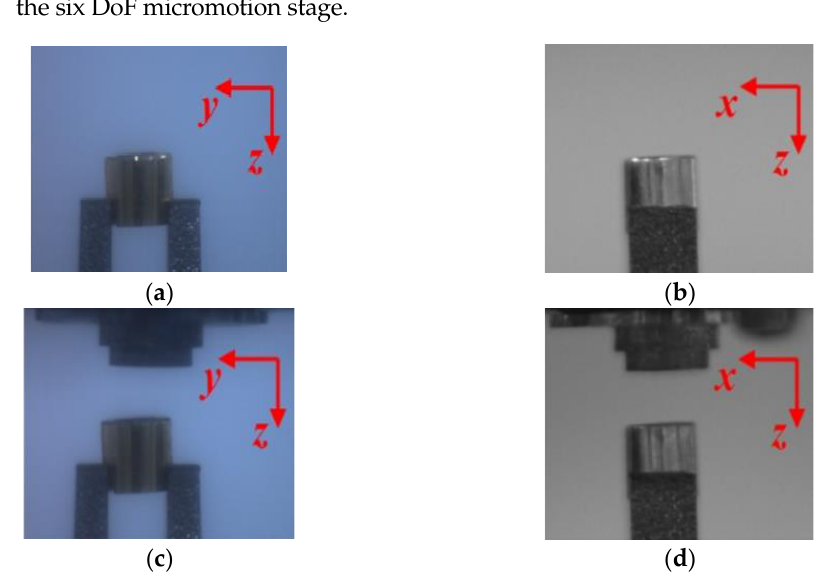
Figure 15. Images of TMP component and hohlraum acquired through the CCD. ( a ) Front view of the hohlraum when unassembled; ( b ) Image of the left side of the hohlraum when unassembled; ( c ) Front view of the sleeve after it enters the assembly area; ( d ) Image of the left side of the sleeve after it enters the assembly area.